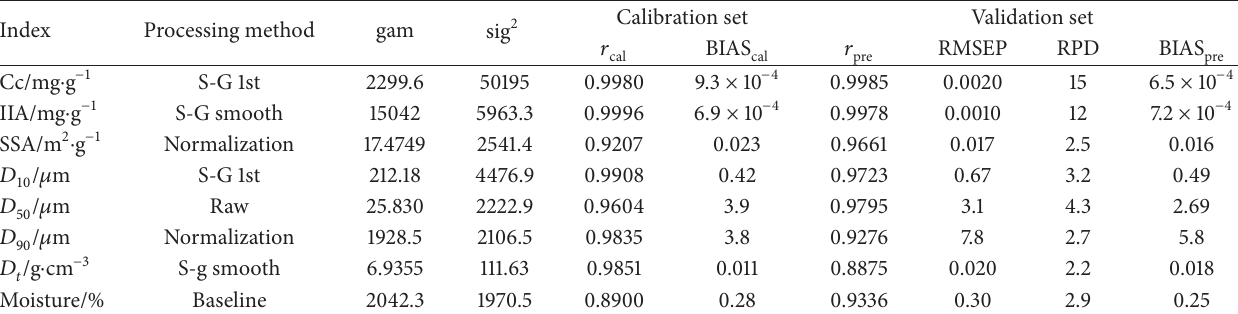
Table 9: The best preprocessing methods for near infrared spectra of the least squares support vector machine model for different quality attributes.